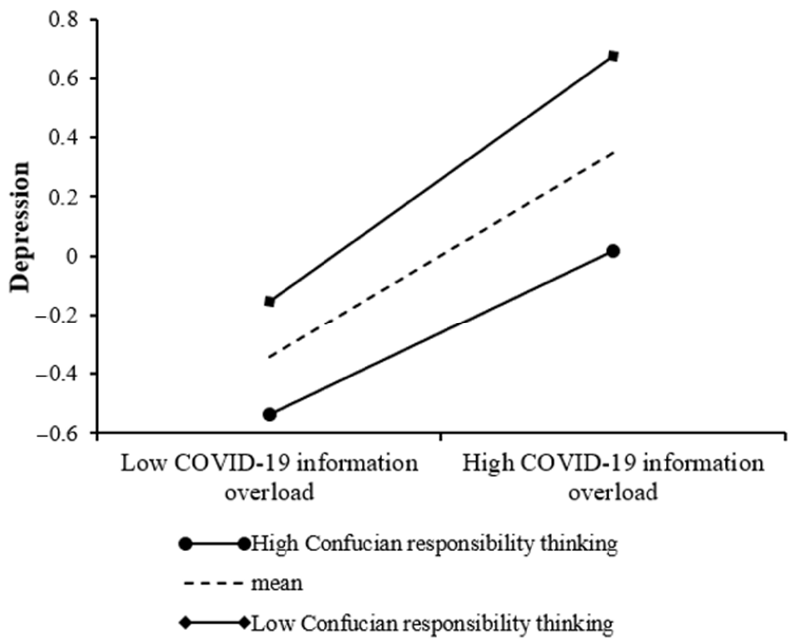
Figure 2. Confucian responsibility thinking moderates the relationship between COVID-19 information overload and depression. Model 2 of Table 4 indicated that the effect of COVID-19 information overload on anxiety was significant ( β = 0.38, p < 0.001), and the interaction of COVID-19 information overload and Confucian responsibility thinking also showed a significant predictive effect on anxiety ( β = − 0.06, p < 0.05). That is, Confucian responsibility thinking moderated the relationship between COVID-19 information overload and anxiety. Specifically, the simple slope test in Figure 3 indicates that the association between COVID-19 information overload and anxiety is significantly stronger for participants with low levels of Confucian responsibility thinking ( β simple = 0.44, SE = 0.04, p < 0.001, 95% CI = [0.36, 0.52]), whereas this positive association is much weaker for participants with high levels of Confucian responsibility thinking ( β simple = 0.33, SE = 0.04, p < 0.001, 95% CI = [0.25, 0.40]), indicating Confucian responsibility thinking’s buffering role in this